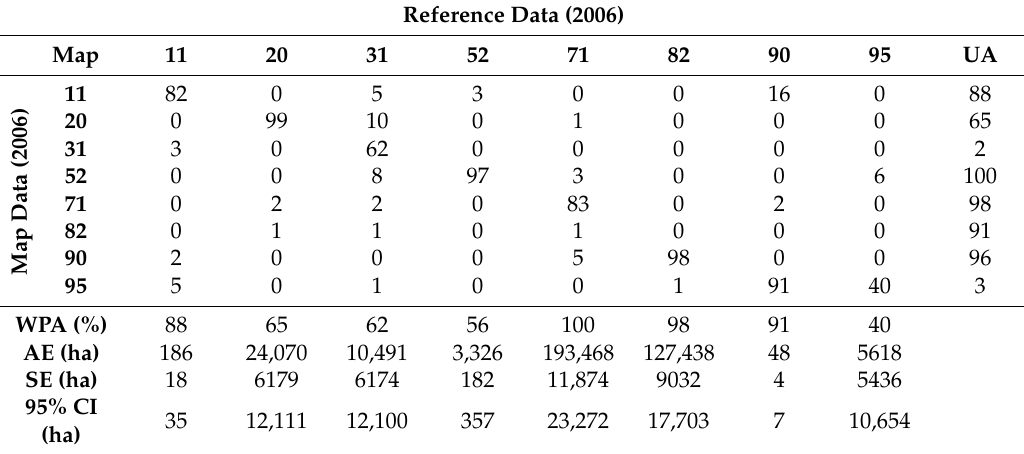
Table A10. Error matrix of Curry County (2006) expressed by Area Weighted Proportions